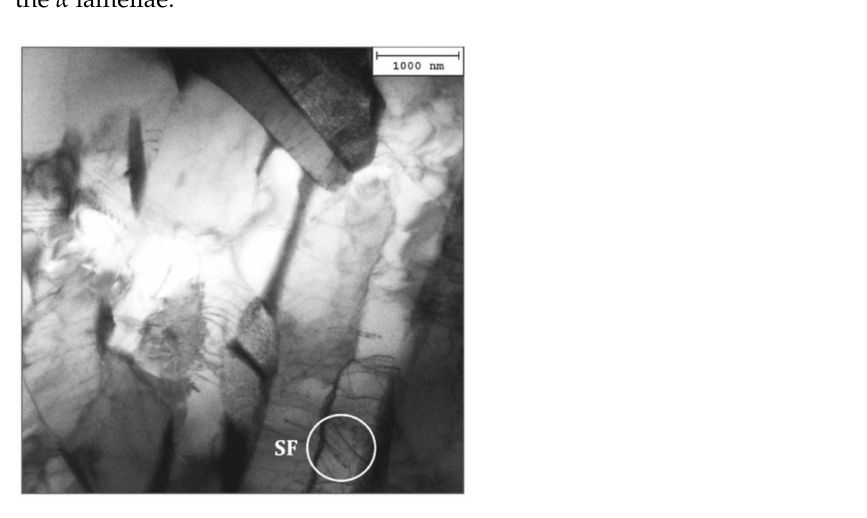
Figure 9. TEM micrographs after 187 h at 650 ◦ C showing the basket-weave α - β lamellar morphology.